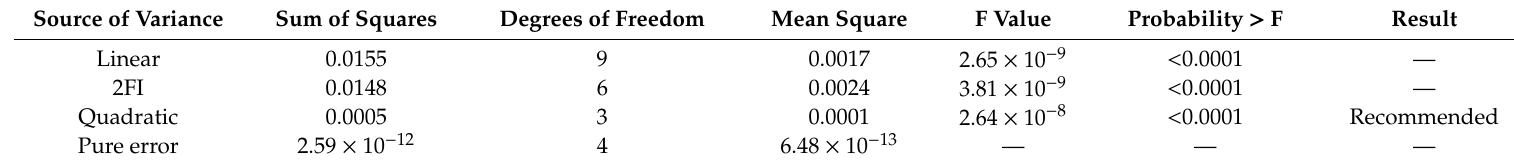
Table 12. Unverified verification.